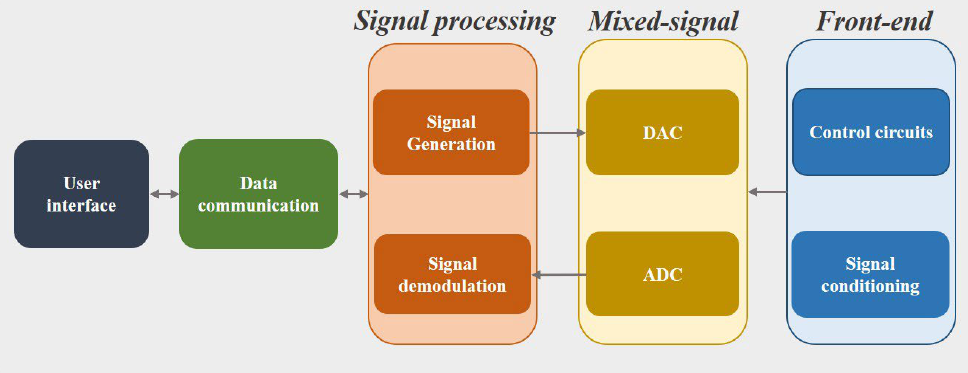
Figure 8. Generic block diagram of EM instruments.